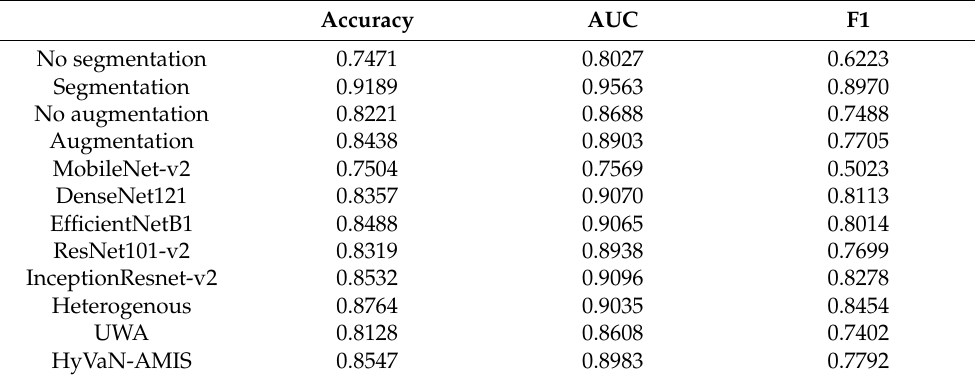
Table 9. The effects of the components contributing to the proposed